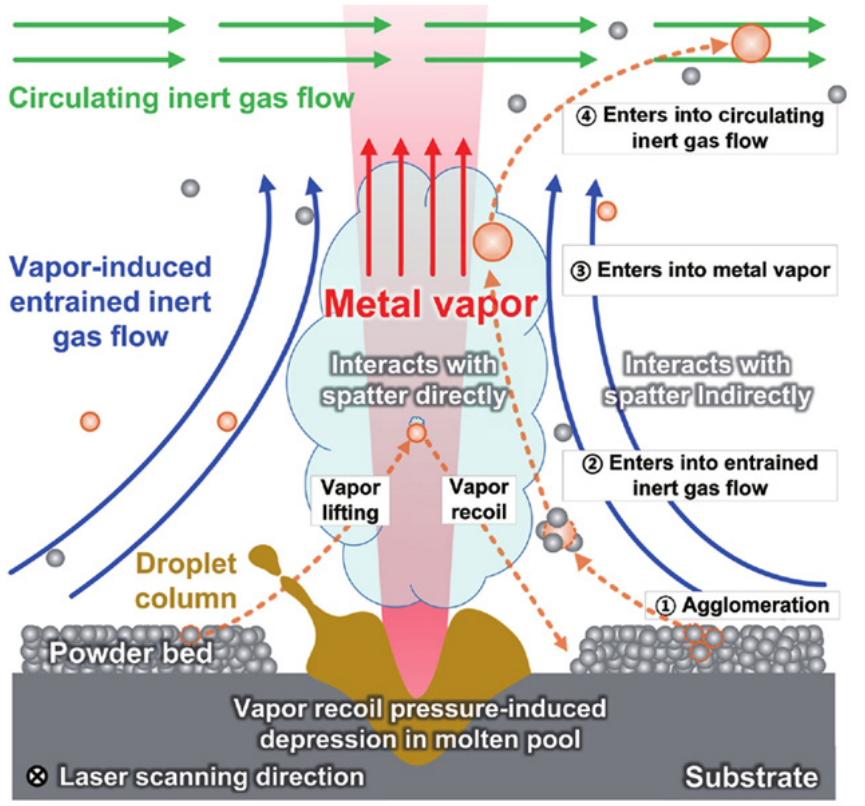
Figure 12. Schematic of spatter ejection process and interaction between vapor plume and spatter behavior in L-PBF. (Reprinted with permission from Ref. [61]. Copyright 2022 Chinese laser press.).